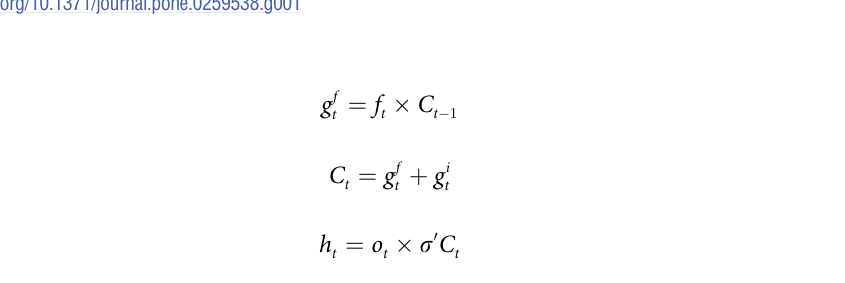
Fig 1. The LSTM framework deployed for the proposed ML+R t method on right, and structure of each LSTM cell on left.